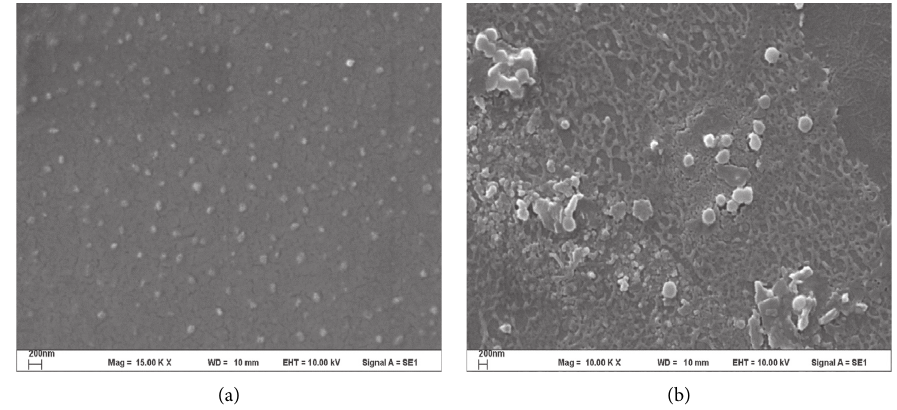
Figure 7: The photographs of the scanning electron microscope. (a) Brij 721, 20%; (b) Myrj 52, 20%.